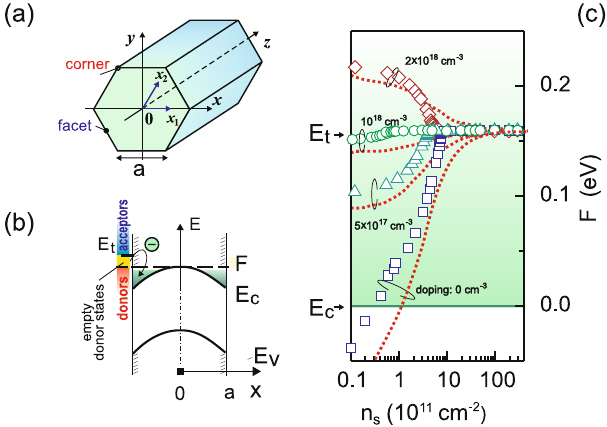
Figure 1. ( a ) Sketch of a nanowire. ( b ) Schematic band diagram of InAs nanowire with the donor- and acceptor-type surface states and electron accumulation region at the nanowire surface where E c and E v denote the conduction and valence band edge, correspondingly, and F is the Fermi level. ( c ) The Fermi level energy as a function of the total surface states density for the intrinsic and n-doped circular InAs nanowire (radius 50 nm) with the doping set to 5 × 10 17 cm − 3 , 10 18 cm − 3 , and 2 × 10 18 cm − 3 and the lattice temperature ( T ) of 4 K (symbols) and 300 K (dotted